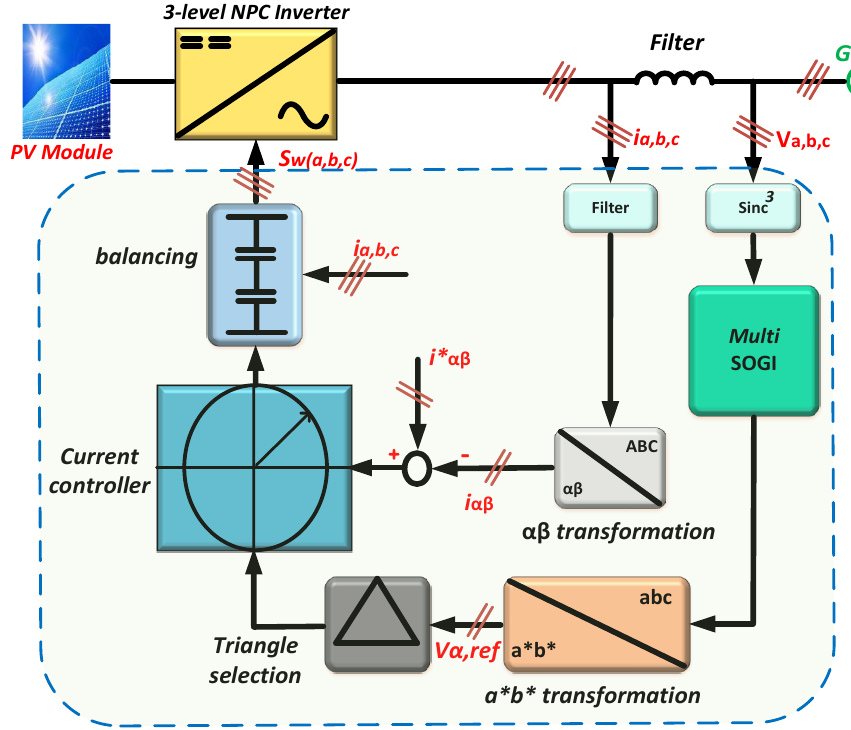
Figure 12. Direct current control (DCC) [137].